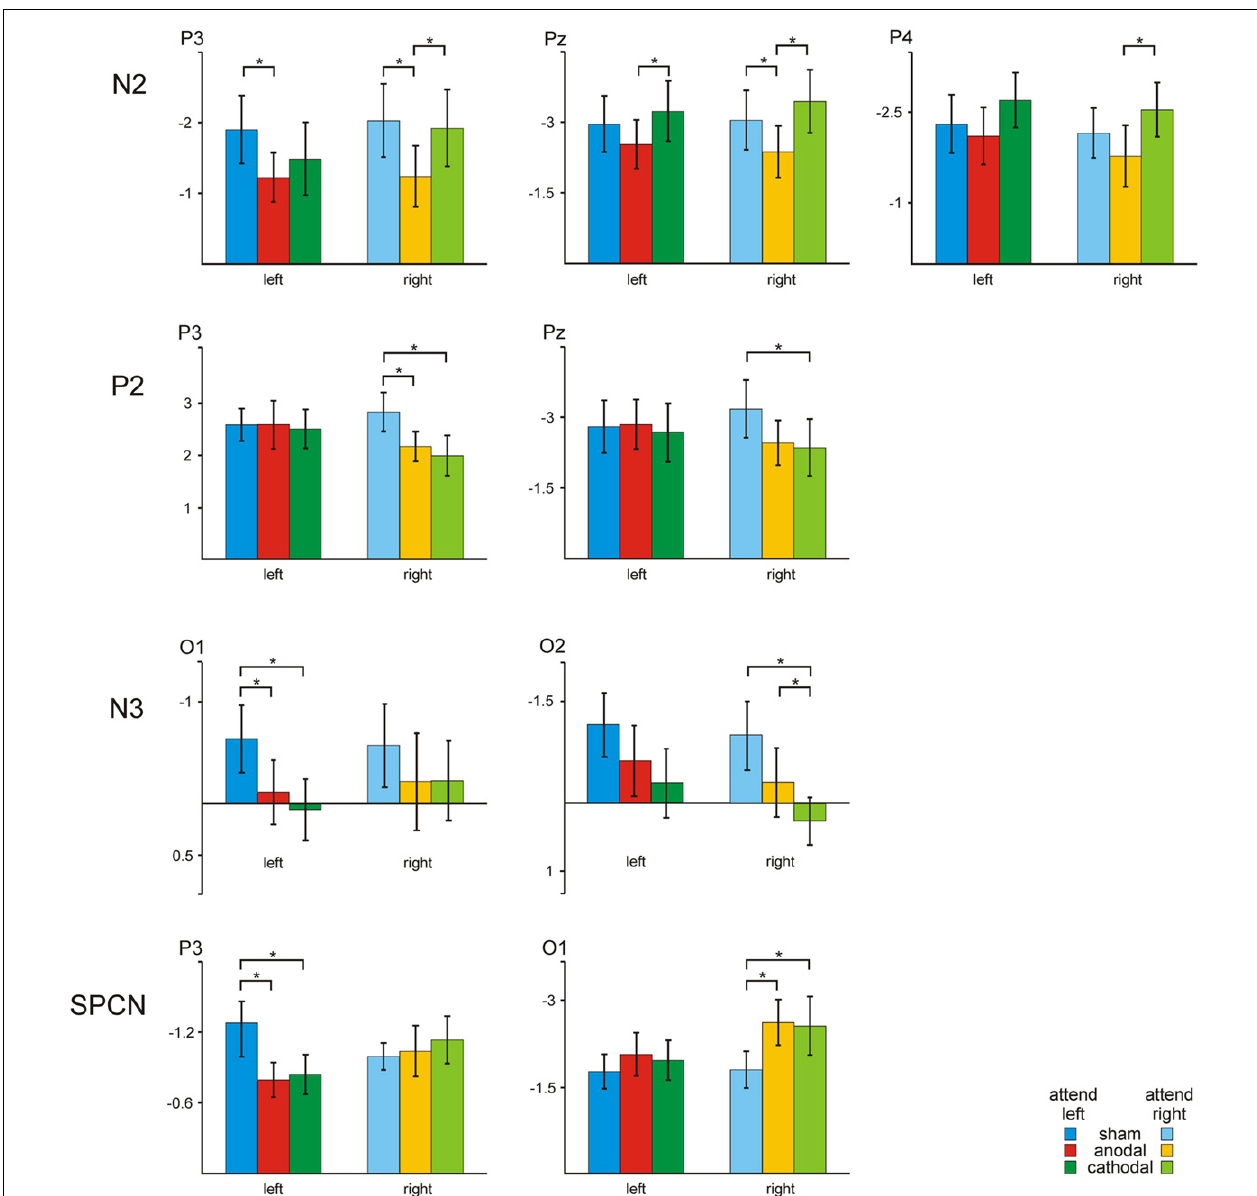
FIGURE 4 |Transcranial direct current stimulation effect on ERP amplitudes: Bar plots show ERP amplitudes at electrodes P3, P4, Pz, O1, and O2 for different conditions (sham, anodal, and cathodal) and the attended hemifield (left,